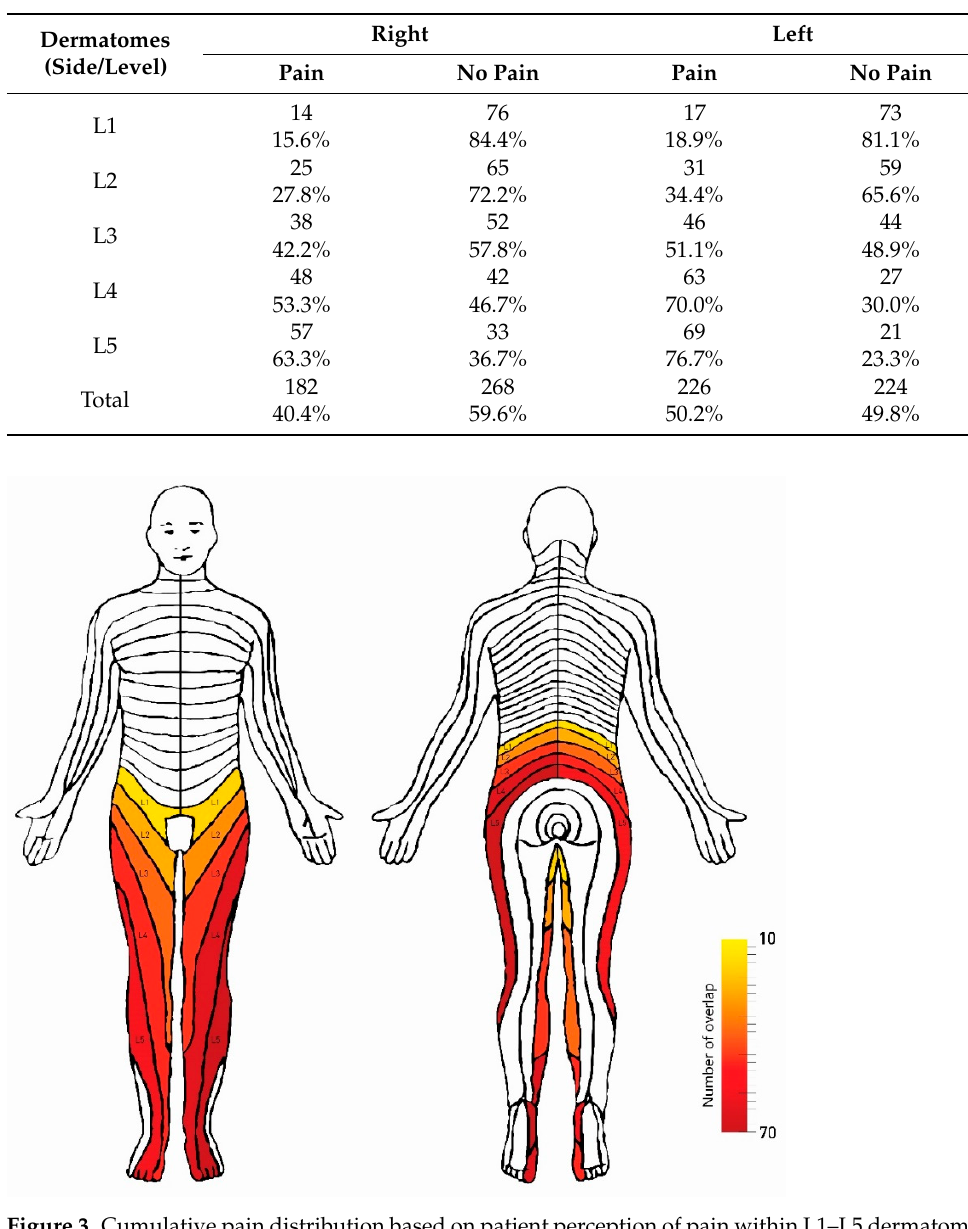
Figure 3. Cumulative pain distribution based on patient perception of pain within L1–L5 dermatomes in a final group of 90 patients.